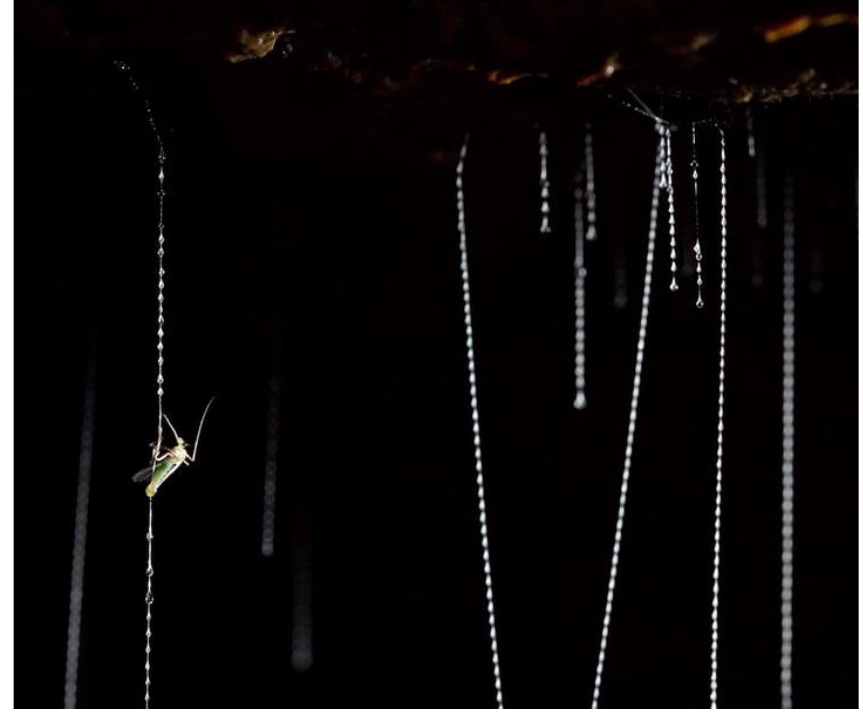
Figure 1. Vertically hanging Arachnocampa tasmaniensis silk threads with a captured insect prey. Copyright: Bookend Trust/SIXTEEN LEGS. Photo credit: Joe